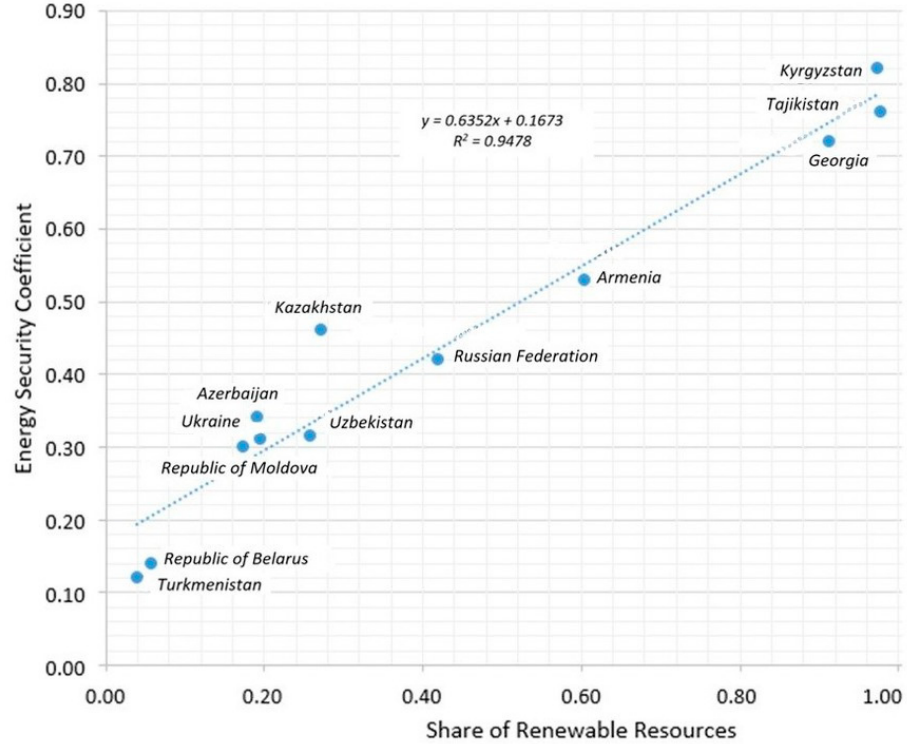
Figure 6. The relation of share of RES and energy security in EECCA according to TES in 2019. Source: compiled by the authors.